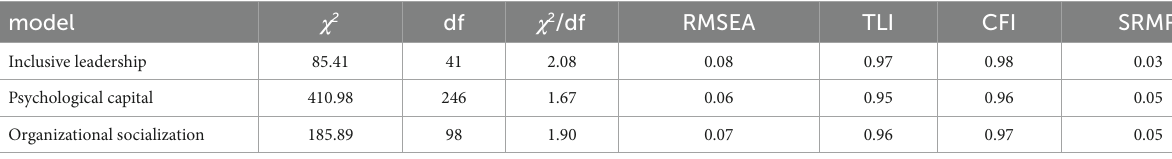
TABLE 4 Confirmatory factor analysis results.